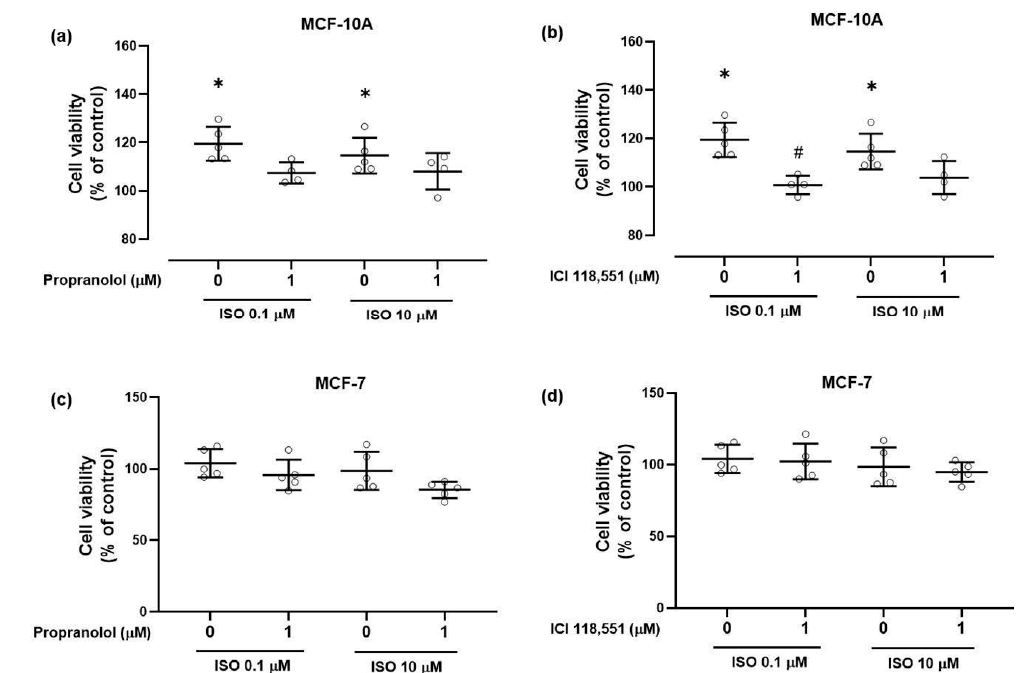
Figure 3. Influence of β -adrenoceptor agonist, isoprenaline (ISO, 0.1 and 10 µ M), alone or in combination with β -adrenoceptor antagonists, ( a , c ) propranolol (1 µ M) or ( b , d ) ICI 118,551 (1 µ M) on cell viability of ( a , b ) MCF-10A and ( c , d ) MCF-7 cells, using the MTT assay. Propranolol and ICI 118,551, per se , did not change cell viability in both cell lines tested (see text). Cells were treated with the indicated drugs for 24 h. Results are expressed as percentage of control (solvent) and are presented as mean ± SD. Values are means ± SD from 4–5 (MCF-10A cells) or 5 (MCF-7 cells) independent experiments, as shown. Significant di ff erences from control group: * p ≤ 0.05; one-way analysis of variance (ANOVA), followed by post-hoc multi-comparisons Dunnett’s test. Significant di ff erences from isoprenaline treatment: * p ≤ 0.05; (Student’s t